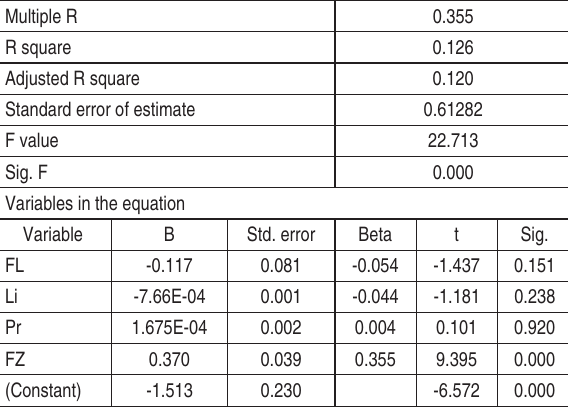
Table 1. The results of multiple linear regression